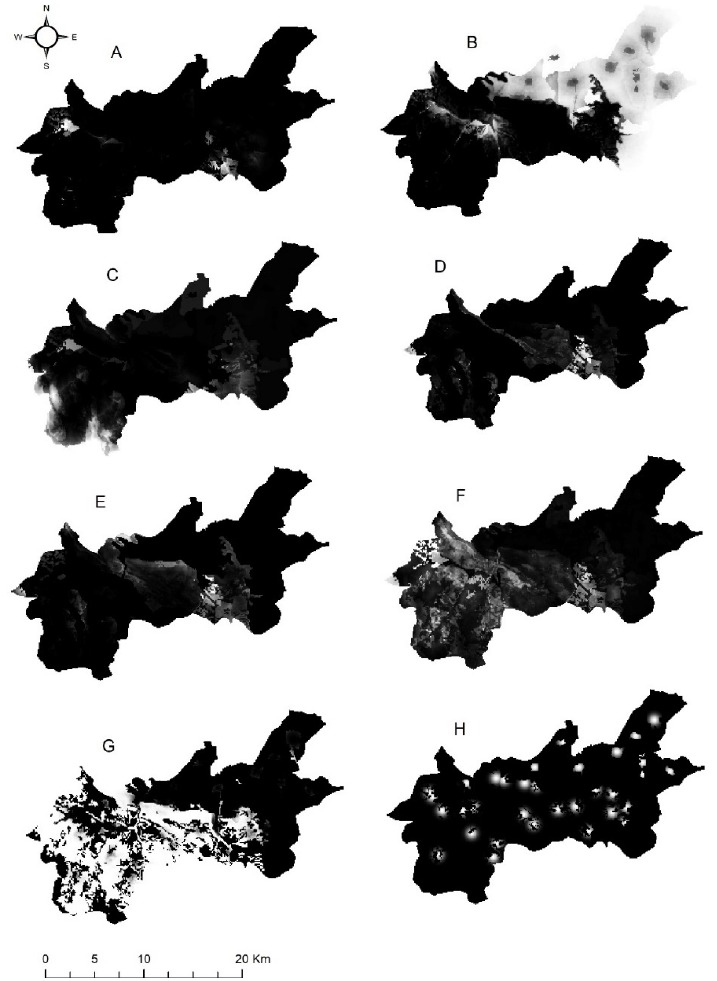
Figure 5. Probability maps for major land use units of the landscape of Mouzaki. Light-colored areas indicate places with a higher probability of occurrence: ( Α ) Silvoarable (0 to 99%), ( Β ) Agricultural land (0 to 99%), ( C ) Grassland (0 to 99%), ( D ) Sparse shrubland (0 to 62%), ( Ε ) Dense shrubland (0 to 71%), ( F ) Silvopastoral woodland (0 to 99%), ( G ) Forest (0 to 100%), and ( Η ) Settlements (0 to 92%).